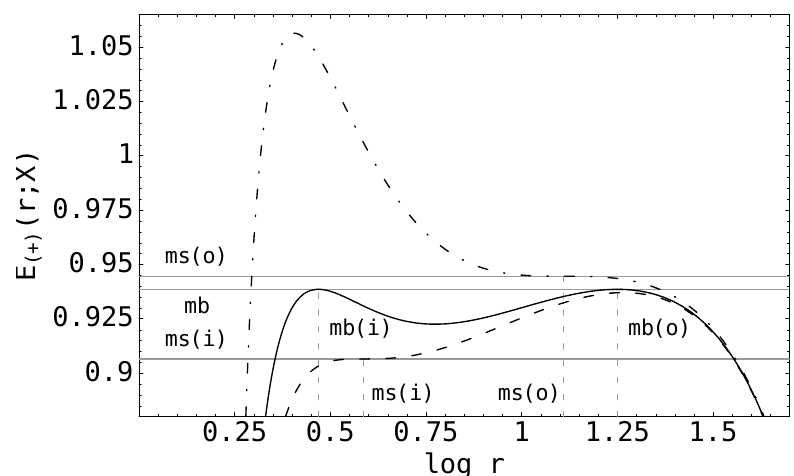
Figure 4. Effective potential of the equatorial radial motion of test particles in the Kerr–de Sitter black-hole spacetime ( y = 10 − 4 , a 2 = 0.36) allowing stable circular orbits for corotating particles. Marginally bound (mb) orbits are given by the solid curve having two local maxima of the same value, corresponding to the inner [mb(i)] and the outer [mb(o)] marginally bound orbits. The dashed effective potential defines the inner marginally stable orbit [ms(i)] by coalescing the local minimum and the (inner) local maximum. Analogously, the dash-dotted potential defines the outer marginally stable orbit